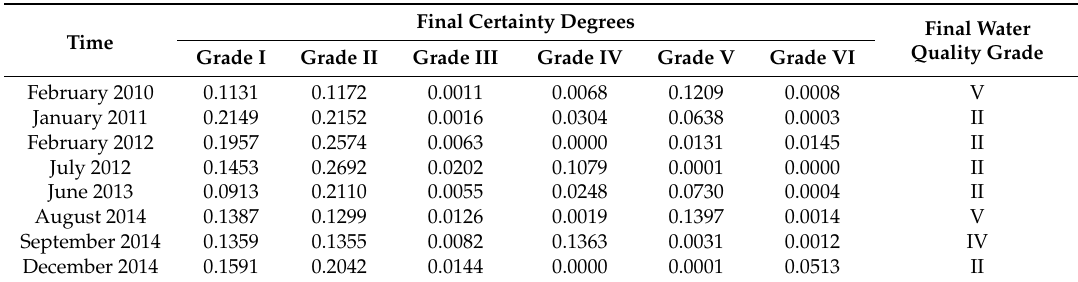
Table 4. Water quality assessed via cloud model-based assessment